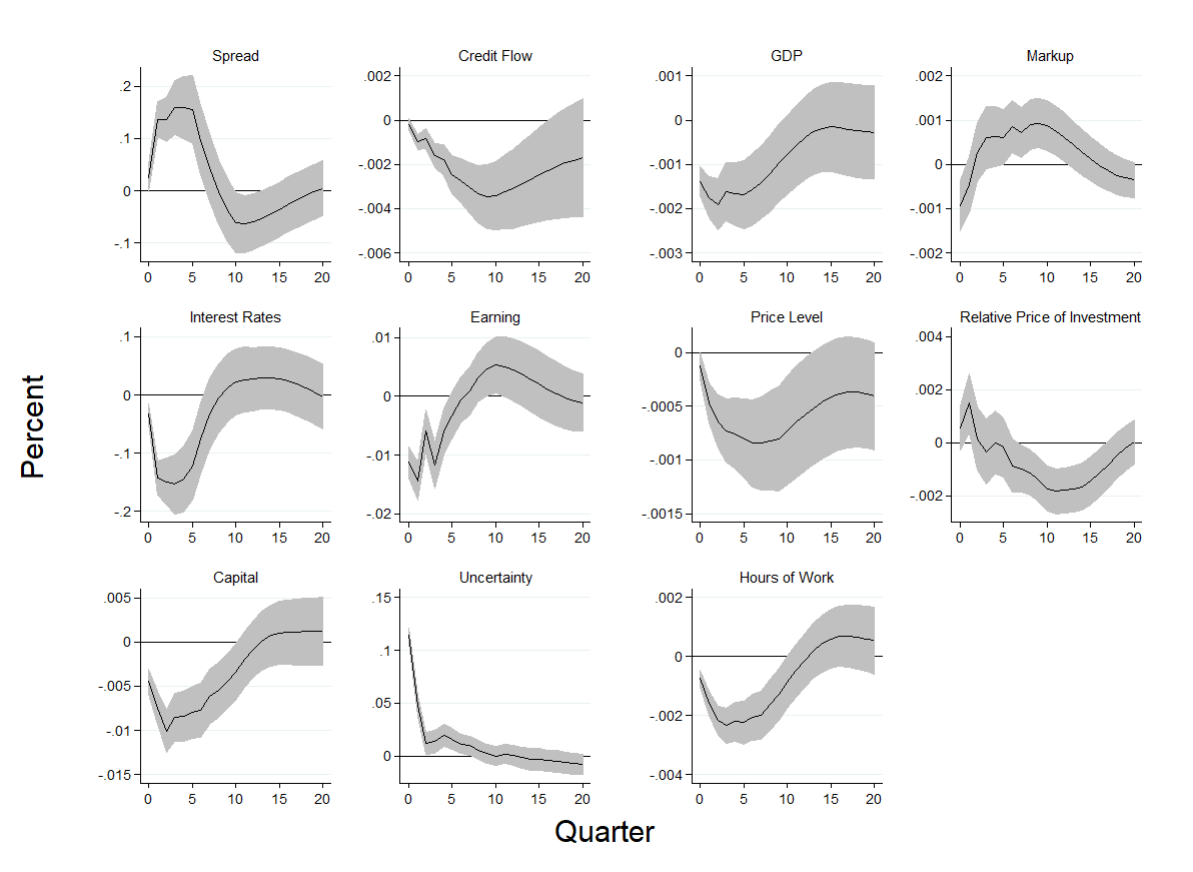
Figure A3. The Effects of Uncertainty Shocks when Economic Policy Uncertainty Index (EPUI) is used as a Proxyy. Notes : Figure A3 shows the effect of one standard deviation increase in EPUI on the US output, Hours, Credit Flow to Non-financial Corporates, Firms’ Capital Stock, Firms’ Earning, the Relative Price of Investment, and markup. In the impulse response functions, the shades represent the one standard deviation confidence interval while the middle bold line represents the median response of variables due to uncertainty increase. The data are quarterly and span the period 1986Q1-2019Q4. In the VAR model, all the variables are in log levels, with the exception of the federal funds